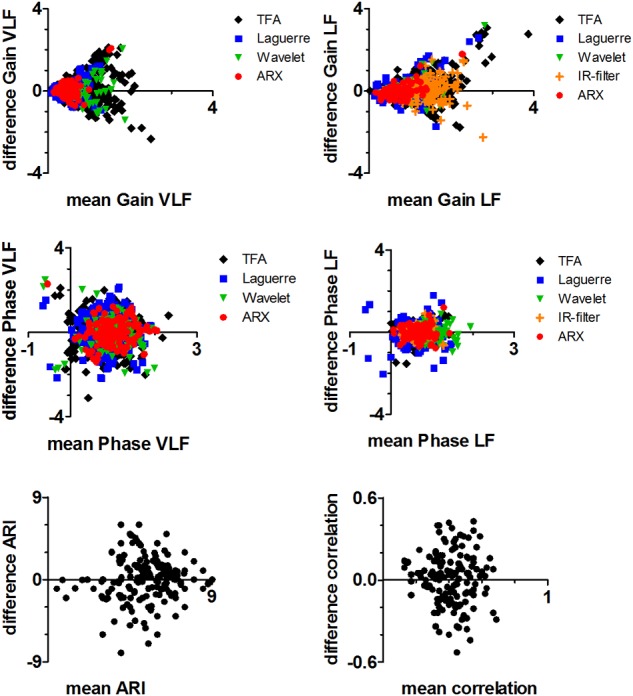
Bland–Altman plot of TFA-like parameters: gain VLF (top left), gain LF (top right), phase VLF (middle left), and phase LF (middle right); ARI-like parameters (bottom left); correlation-like parameters (bottom right). Units are similar to Figure 1A,B.